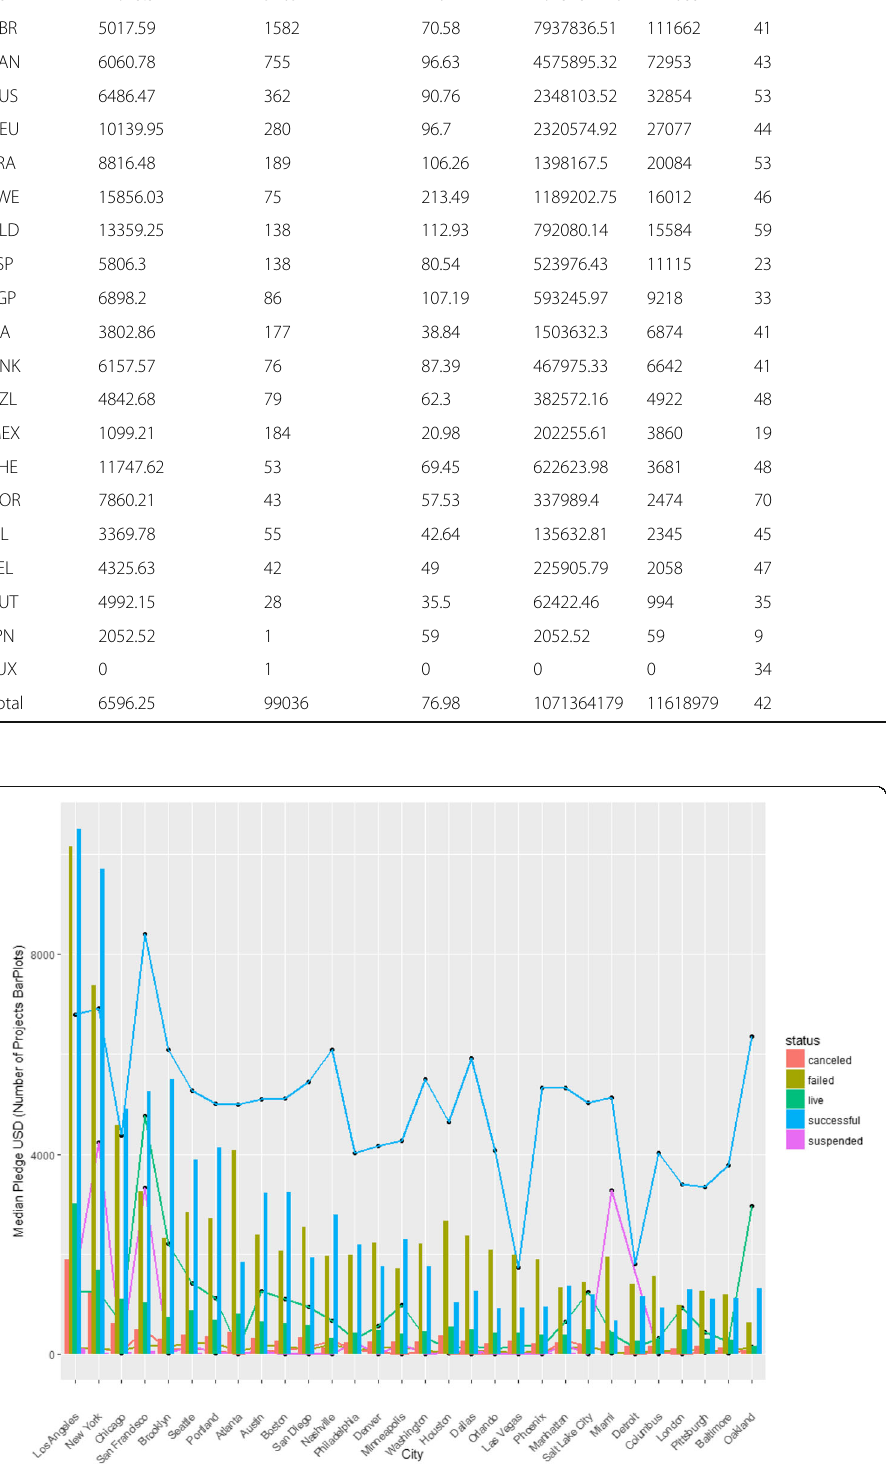
Fig. 2 Bar plot of the number of projects with line representing the median pledge in